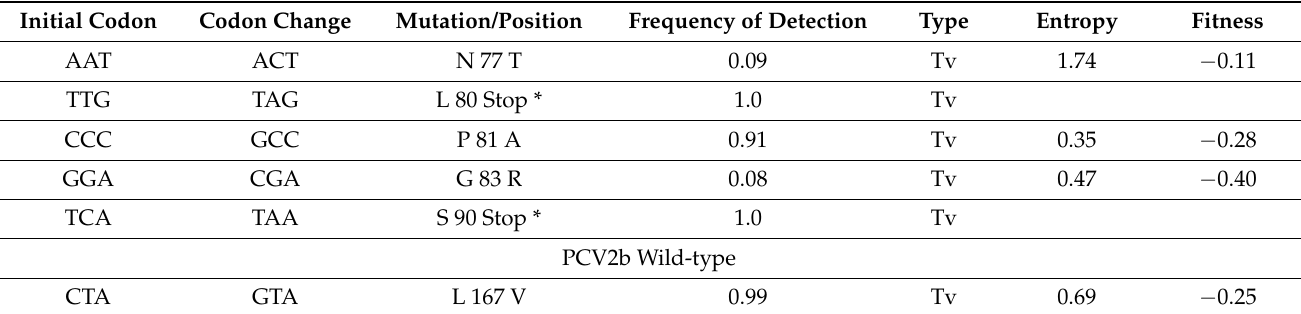
Shaded text—target recoded serine and leucine codons; * recoded serine or leucine codons that mutated to stop codons. Ti—transition, Tv—transversion; entropy score—Shannon’s sequence entropy score from DeMaSk. Higher values indicate residues with a greater tendency toward substitution. Low